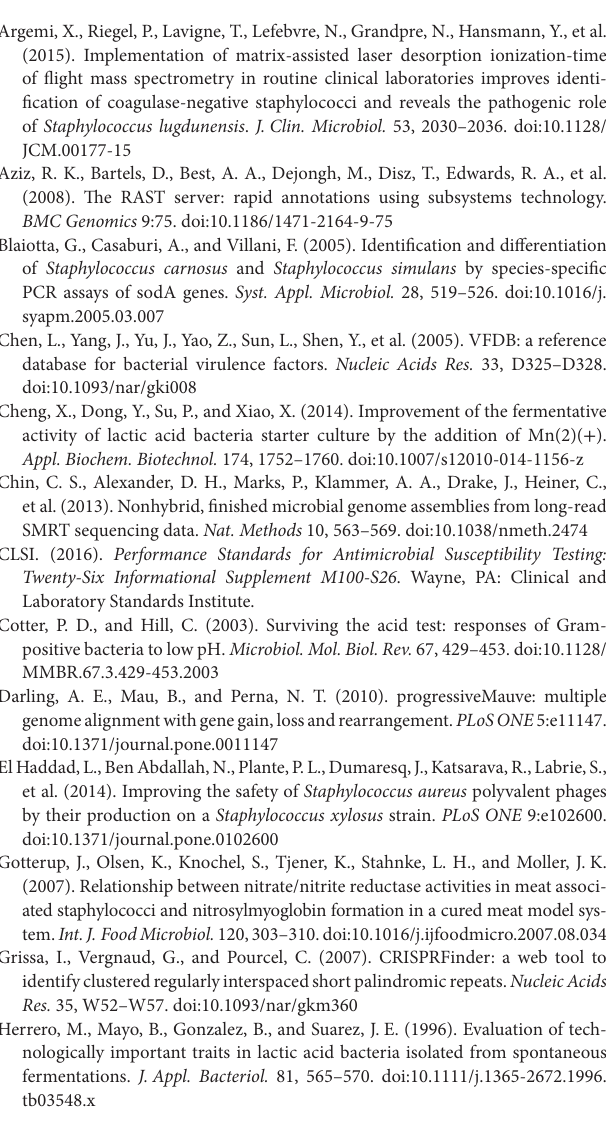
activity of S. condimenti DSM 11674. Enzyme activity was measured as spectrophotometric methods. Staphylococcus aureus ATCC 25923 and clinical isolate S. condimenti CJ1628 were used for comparison. FIGURe S2 | Genome atlas of Staphylococcus condimenti DSM 11674. The circles represent (from the outside to the inside): circle 1, reverse CDS (cyan); circle 2, forward CDS (yellow); circle 3, tRNAs (blue); circle 4, rRNAs (red); circle 5, GC plot; and circle 6, GC skew. FIGURe S3 | Genomic comparison of the Staphylococcus condimenti DSM 11674 with starter culture strains Staphylococcus carnosus TM300 and Staphylococcus xylosus SMQ121 by Mauve. Alignment is represented as local collinear blocks (LCBs) filled with a similarity plot. LCBs of conserved sequences among the strains are represented by rectangles of the same color. Connecting lines can be used to visualize synteny or rearrangement. LCBs positioned above or under the chromosome (black line) correspond to the forward and reverse orientation, respectively. The level of conservation is equivalent to the level of vertical color filling within the LCBs. Sequences not placed within an LCB are unique for the particular